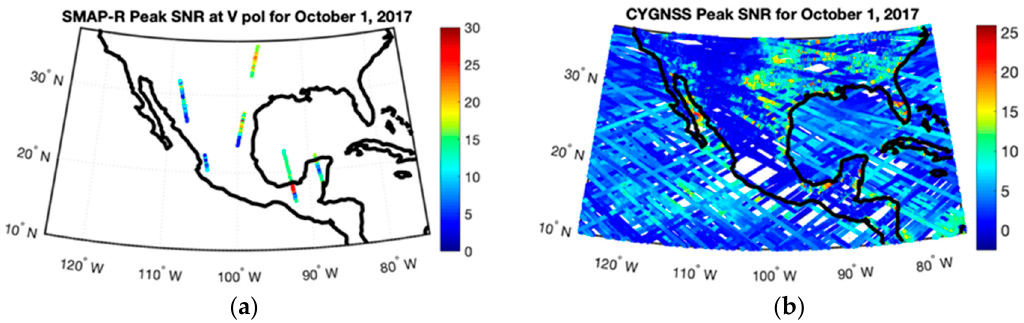
Figure 3. Peak signal to noise ratio (SNR) of the GPS reflections, captured by ( a ) SMAP-R at V-polarization with 25 ms integration time and ( b ) CYGNSS, for 1 day of measurements with 1,000 ms integration time. Peak SNR plotted in dB.